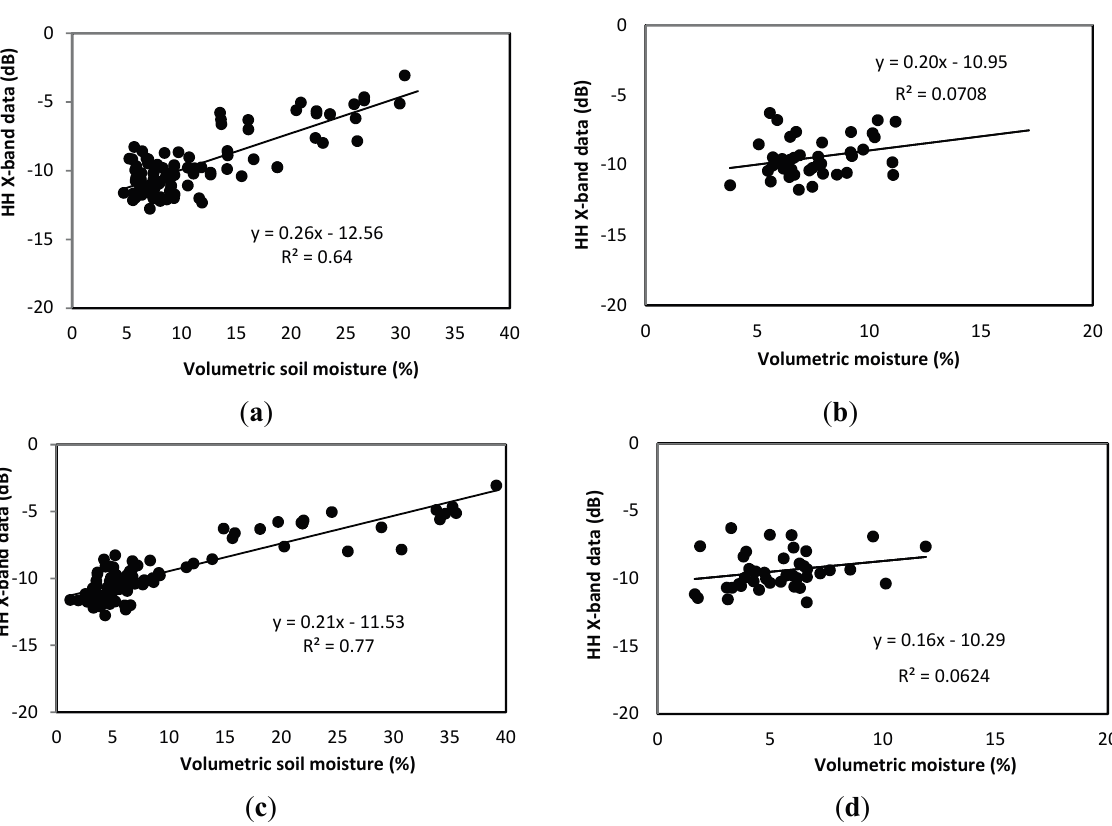
Figure 6. Relationships between backscattering coefficient and measured volumetric soil moisture in the HH polarization: ( a , b ) for moisture measured with a thetaprobe instrument at a depth of 5 cm, at 36° and 26° incidence; ( c , d ) for moisture measured by gravimetric sampling at a depth of 2 cm, at 36° and 26°